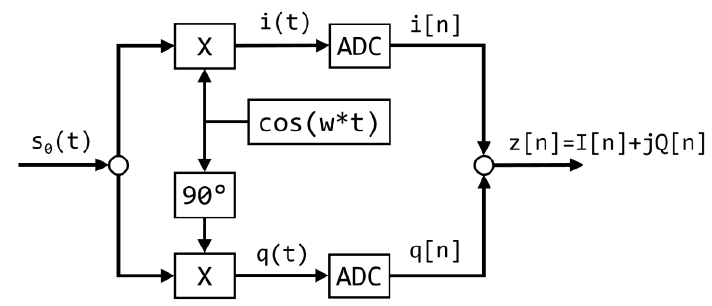
Fig. 2. Scheme of the quadrature demodulator of the complex envelope of the